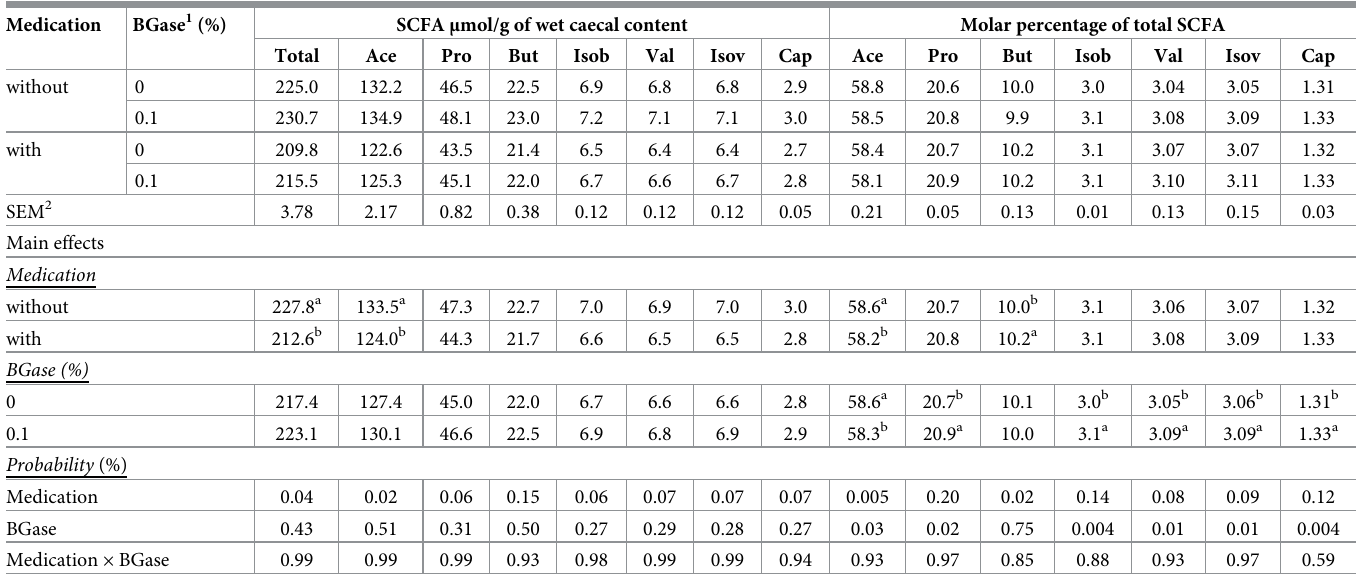
Table 13. Effects of diet medication and β -glucanase on caecal short chain fatty acids of broiler chickens aged 33 days (Experiment 2). Medication BGase 1 (%) SCFA μ mol/g of wet caecal content